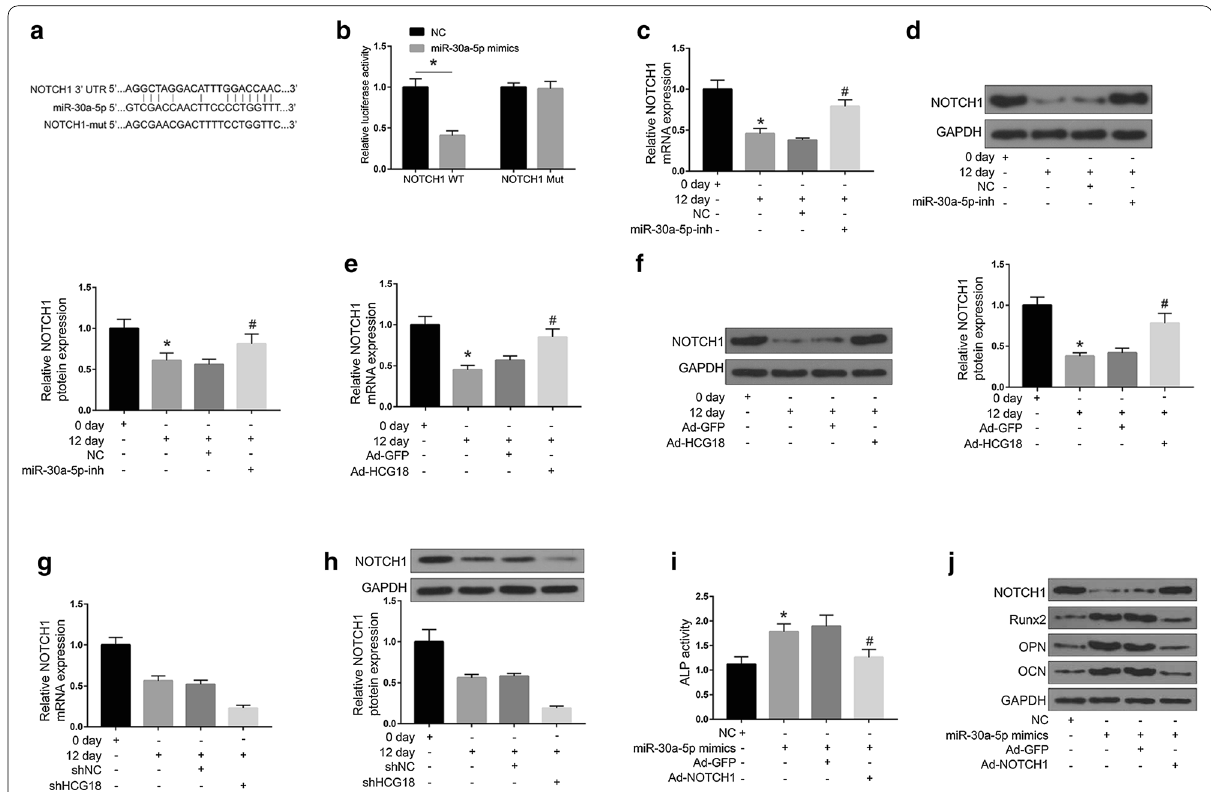
Fig. 4 Effect of miR-30a-5p and NOTCH1 on osteogenic differentiation of BMSCs. a Putative binding sites for NOTCH1 and miR-30a-5p. b Luciferase activity of NOTCH1-wt and NOTCH1-mut in miR-30a-5p mimics or NC-treated BMSC cells. c Effect of overexpression of miR-30a-5p on the expression of NOTCH1. d Effect of overexpression of miR-30a-5p on the expression of NOTCH1 protein. e Effect of overexpression of HCG18 on the expression of NOTCH1. f Effect of overexpression of HCG18 on the expression of NOTCH1. g Effect of HCG18 knockdown on NOTCH1 mRNA expression. h Effect of HCG18 knockdown on NOTCH1 protein expression. i ALP activity assay. j Determination of the expression of osteogenic differentiation specific markers (Runx2, OCN, OPN). * P < 0.05. The OP-BMSCs were from one human subject and the experiments were performed